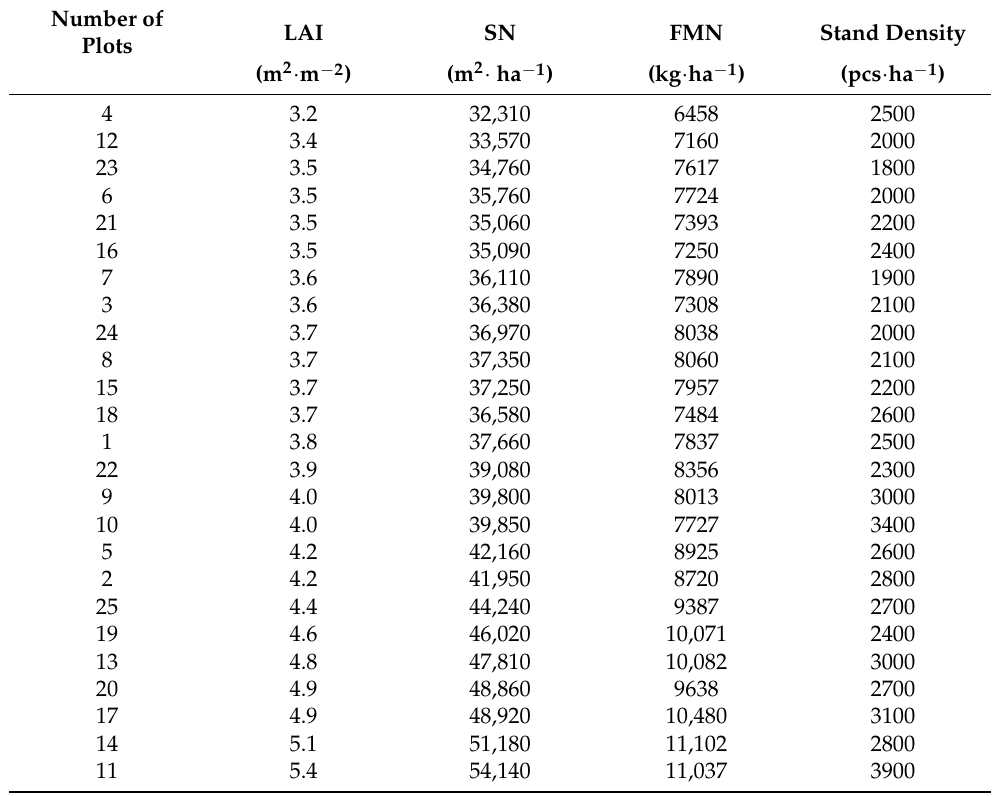
Table 3. Differences in needle surface area in 33 years old Scots pine stand (data sorted in ascending order by LAI). Number of